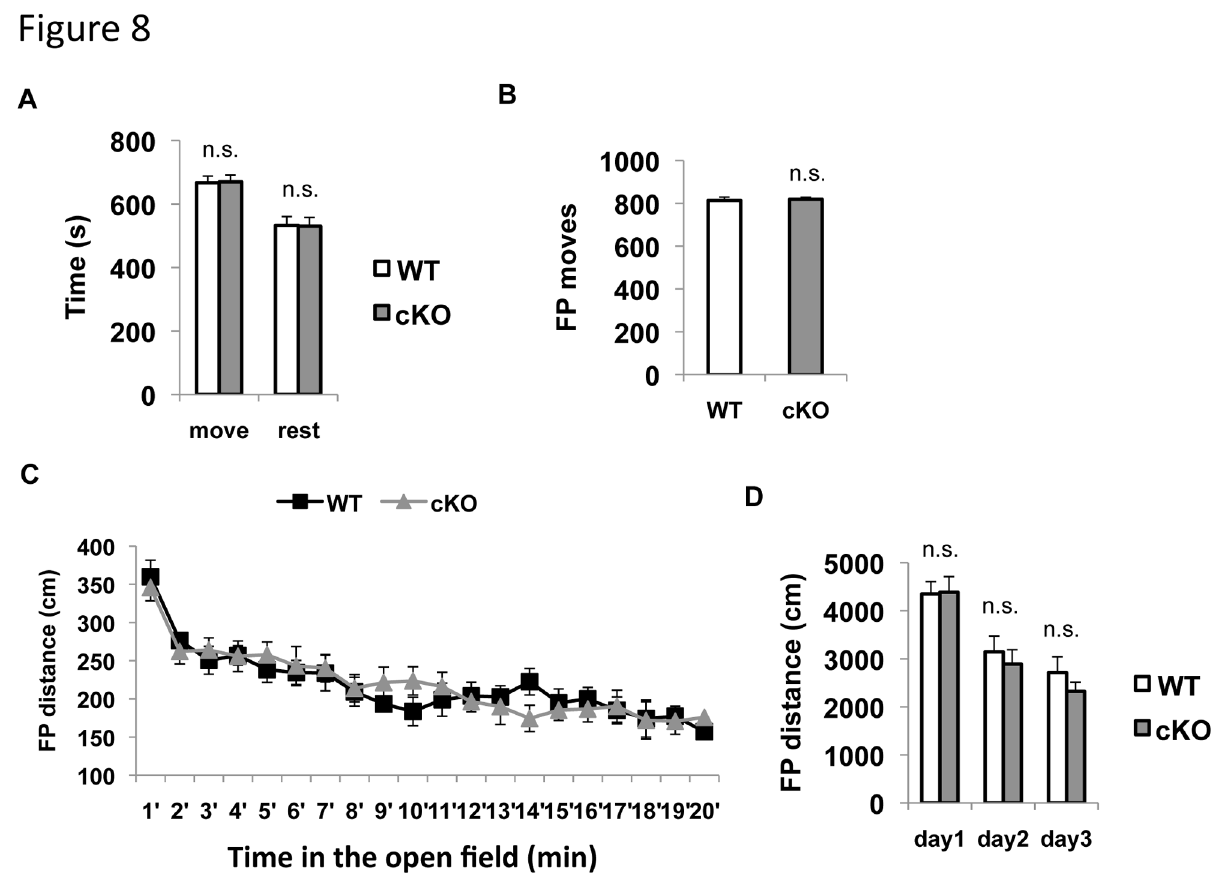
Figure 8. ERK5 deletion does not alter the levels of mobility and activity in an open field test. Mice were subjected to an open field assay on three consecutive days with a 20-min trial on each day. A , Total time spent in moving or resting in the first day of the test. B , Total number of floor plane (FP) moves during the first day of the open field training. C . ERK5 deletion does not affect the habituation of the mice to the open field area on the first day of the training. The 20-min trial of the first day training was computationally split into 20 segments with 1 min per segment and the FP moving distance in each segment was measured. Both ERK5 cKO and WT mice moved actively in the first segment and the movement declined as they habituate to the open field. D , Both ERK5 cKO and WT male mice habituated similarly to the open field arena during repeated exposure in 3 consecutive days. Their activity was quantified by the FP distance traveled on each day. n.s., not significant.